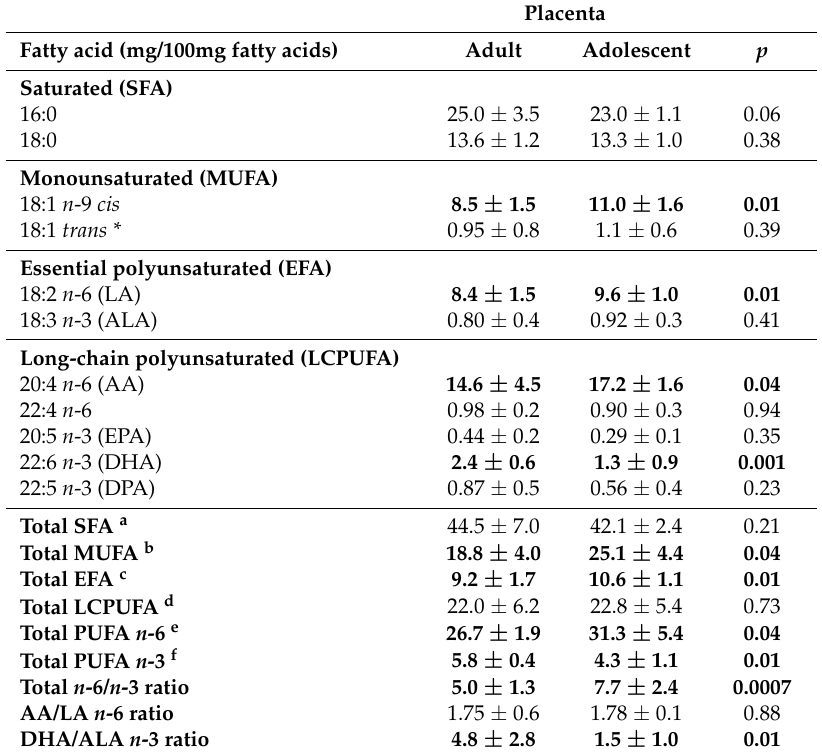
Table 4. Placental fatty acid concentrations in adult and adolescent